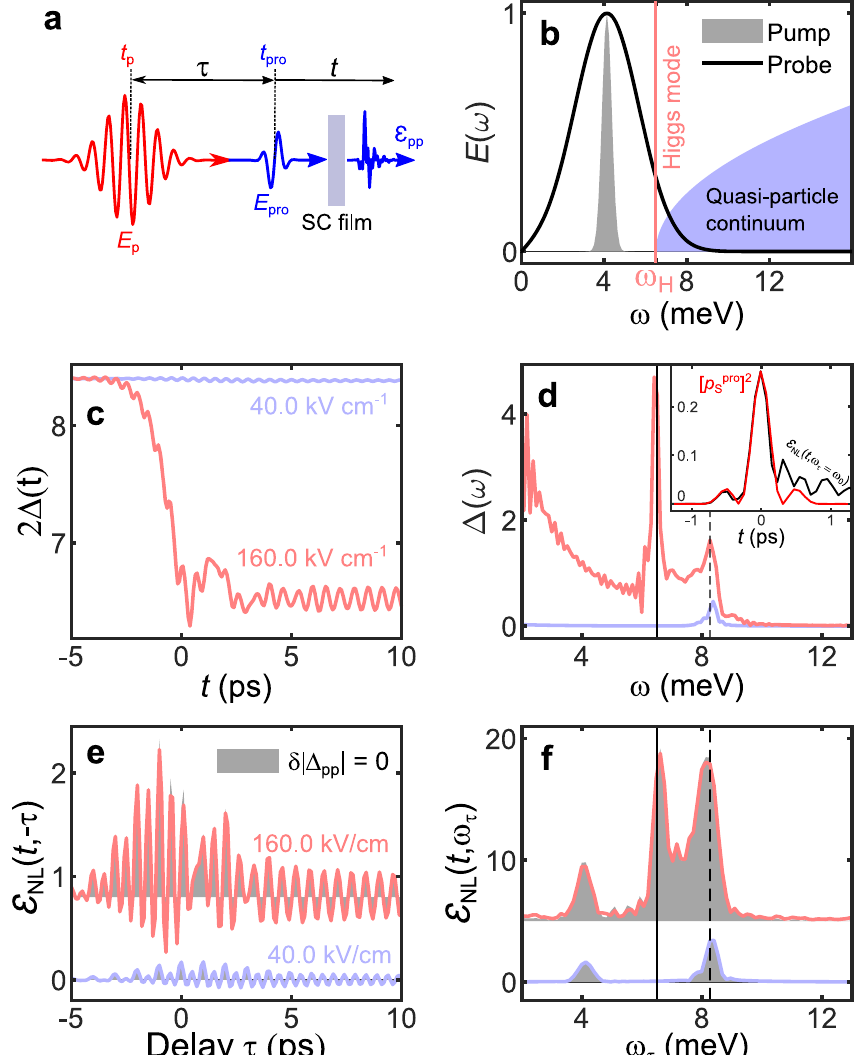
Fig. 1 Phase-coherent nonlinear terahertz (THz) spectroscopy. a Schematic representation of the two-dimensional terahertz con fi guration used here. The superconducting (SC) system is excited by collinear phase-locked pump and probe pulses. The probe electric fi eld E pro is centered at t pro = 0 ps while the pump electric fi eld E p is centered at t p = τ such that τ = t p − t pro corresponds to the pump-probe delay. E pp is the transmitted electric fi eld after excitation of the SC fi lm with pump and probe pulses. b Spectra E ( ω ) of narrowband pump (gray shaded area) and broadband probe (solid line) laser pulses used here, with central frequency ω 0 = 1 THz. The amplitude Higgs mode frequency ω H (quasi-particle continuum) for a pump- fi eld strength of 160.0 kV cm − 1 is indicated by a vertical red line (purple shaded area). c , d Dynamics and spectra of the order parameter Δ for two different pump fi eld strengths and fi xed probe fi eld strength. The order parameter spectra Δ ( ω ) show a second harmonic generation peak (vertical dashed line) and a Higgs mode peak at the Higgs mode frequency ω H (vertical solid line), which separate in frequency for high pump fi elds (red line), but merge into one peak for lower fi elds (purple line, third-order susceptibility regime). e , f The corresponding dynamics and spectra of the nonlinear differential transmission E NL ð t ; ω τ Þ at a fi xed sampling time t = 0 ps. Traces are offset for clarity. The result of the calculation without pump-probe coherent modulation of the order parameter, δ Δ pp = 0 (shaded area), is close to that of the full calculation (solid line), which indicates that collective effects do not play a major role here. In addition to the two peaks of the order parameter spectrum in d , the one-dimensional pump-probe spectrum shows a third peak at ω τ = ω 0 , which results from inversion-symmetry breaking by the probe-induced condensate momentum. Inset of d : The t -dependence of the ω τ = ω 0 inversion-symmetry breaking peak strength (black ð t Þ(cid:2) 2 (red line) where p pro ð t Þ is probe-induced condensate center-of-mass line) follows that of ½ p pro S S